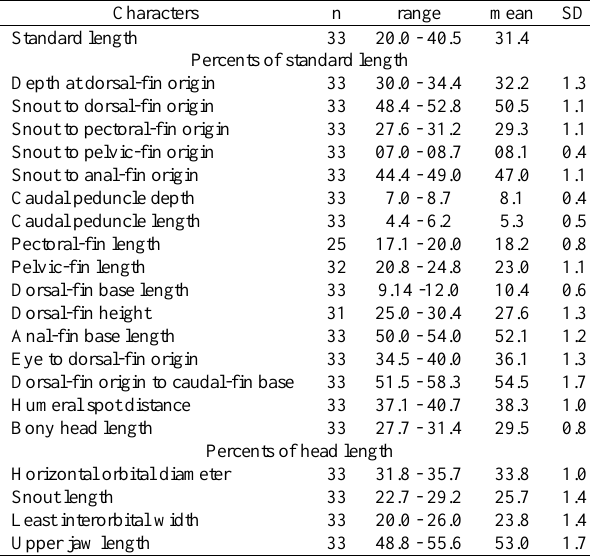
Table 6 . Morphometrics of Charax hemigrammus . Specimens are from MZUSP 100354, 76217, 76248,